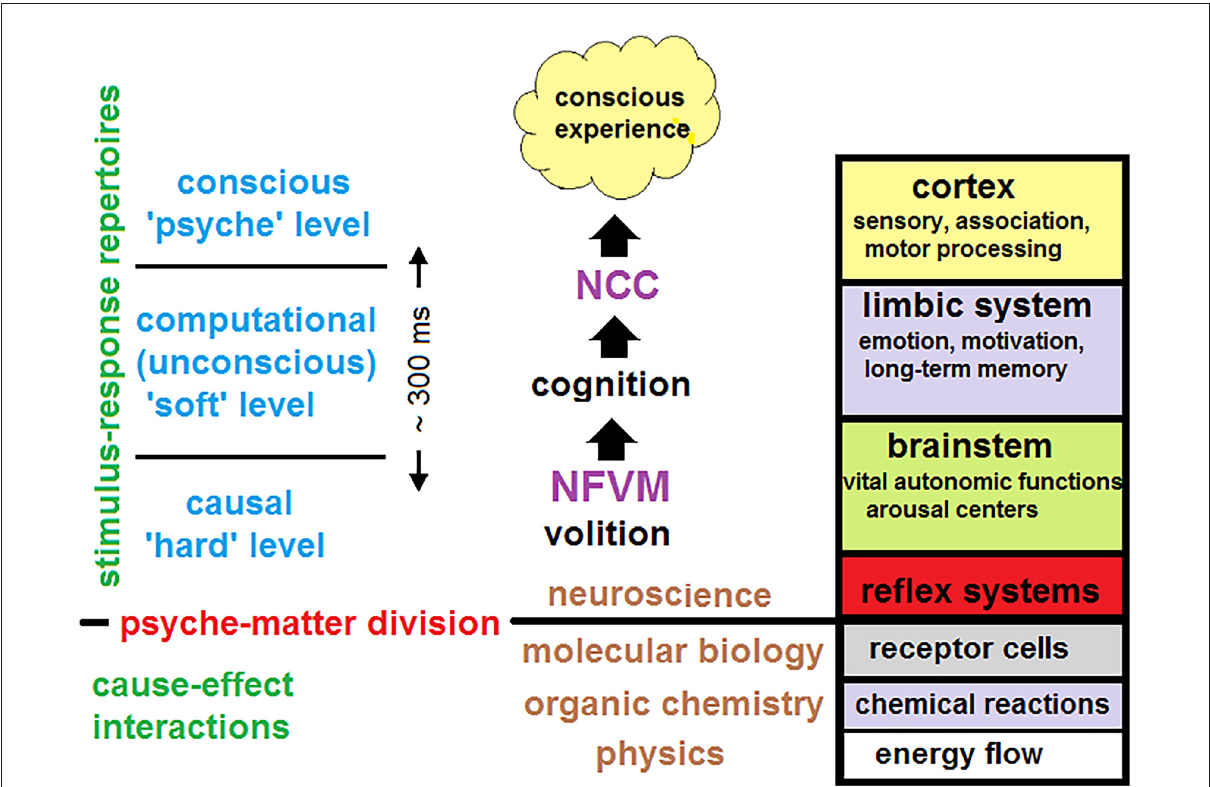
FIGURE3 The origins of consciousness. CET starts from the assumption that the brain should have primarily evolved as volitional subsystems of organisms from simplest neural reflexes based on chemoreceptor, magneto- and photoreceptor cells sensitive to quantum effects. At the causal (hard) level, the volitional subsystems should provide a principled psyche-matter division between organisms, exploiting their stimulus-reactions repertoires freely, and non-living systems, governed completely by cause-effects interactions. Placing the NFVM into the brainstem, the oldest brain region that integrates functions of many vital systems and is responsible for arousal and vigilance guarantees that each conscious state will be triggered free of predetermination from the